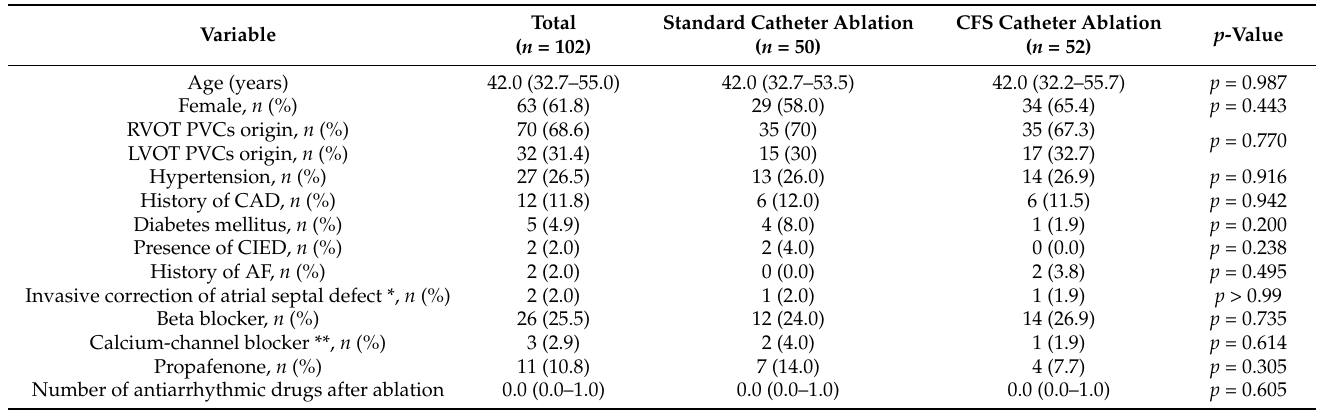
Table 1. Patient characteristics.